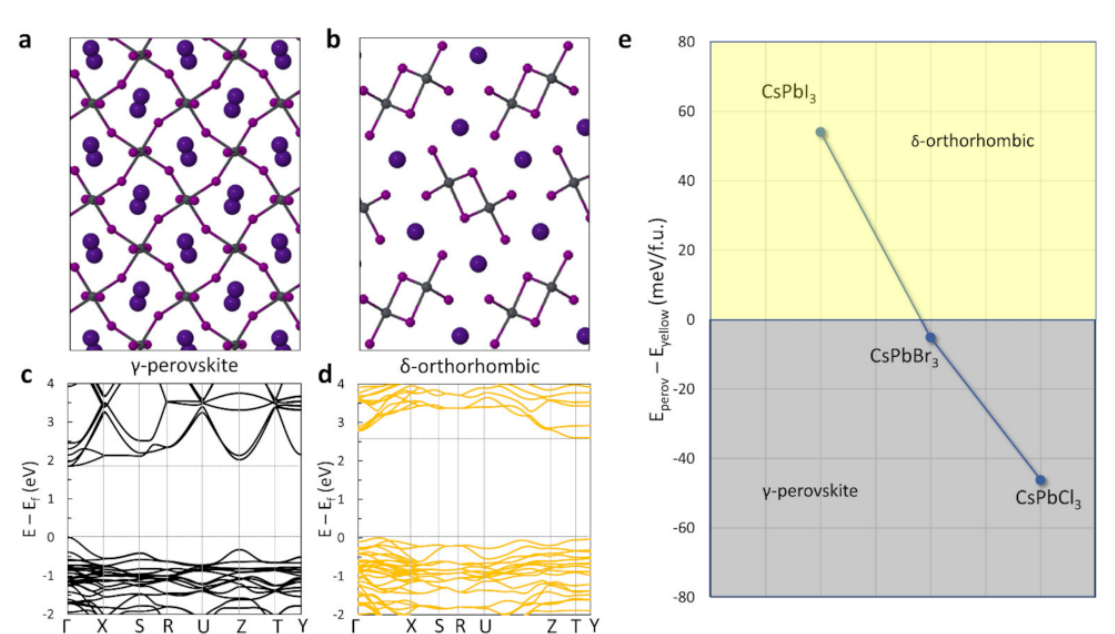
Figure 1. ( a ) Scheme of the γ -CsPbI 3 perovskite phase seen from the (001) plane; ( b ) Scheme of the orthorhombic δ -CsPbI 3 yellow phase seen from the (010) plane; ( c ) Band structure of the γ -CsPbI 3 perovskite phase; ( d ) Band structure of the orthorhombic δ -CsPbI 3 yellow phase; ( e ) Difference in the calculated ground state energy (at 0 K) between the γ and the δ phases of CsPbX 3 perovskites (where X = I, Br, Cl).